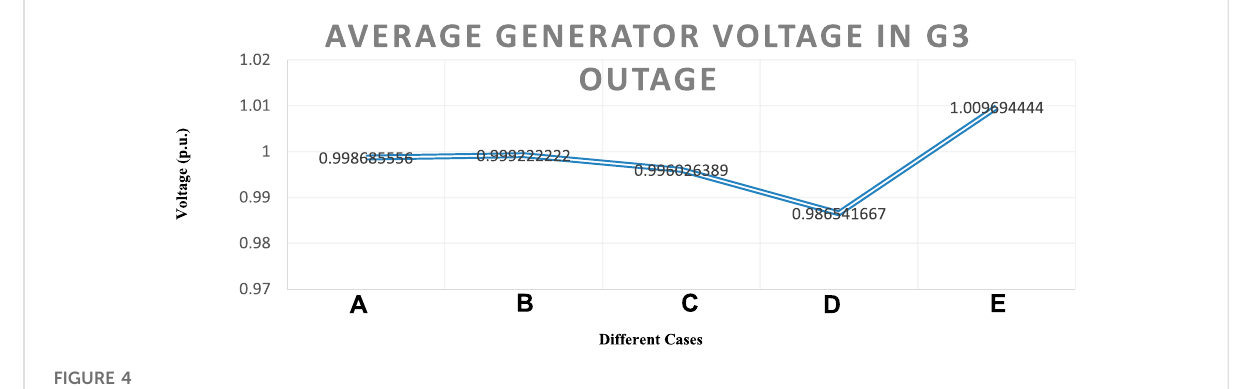
FIGURE 4 Average voltage of remaining generators in case of G 3 outage in all